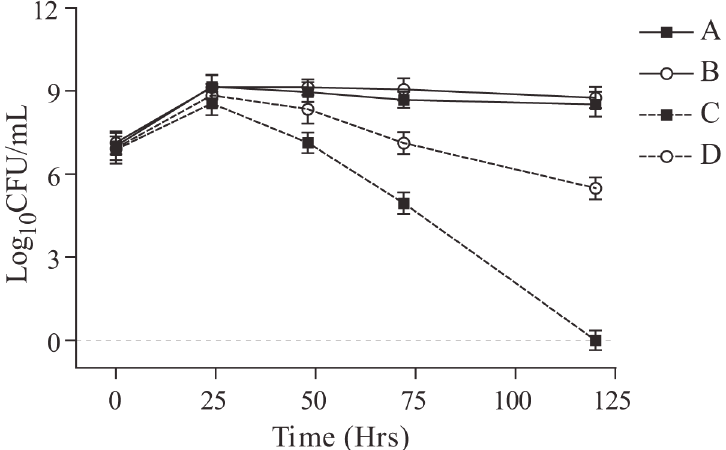
Figure 1. Effect of temperature on the survival of P. putida NBRI1108 and NBRI1108T. Treatments are designated as (A) NBRI1108 at 28 ± 2°C, (B) NBRI1108T at 28 ± 2°C, (C) NBRI1108 at 40°C and (D) NBRI1108T at 40°C. Values are the mean ± SE of three